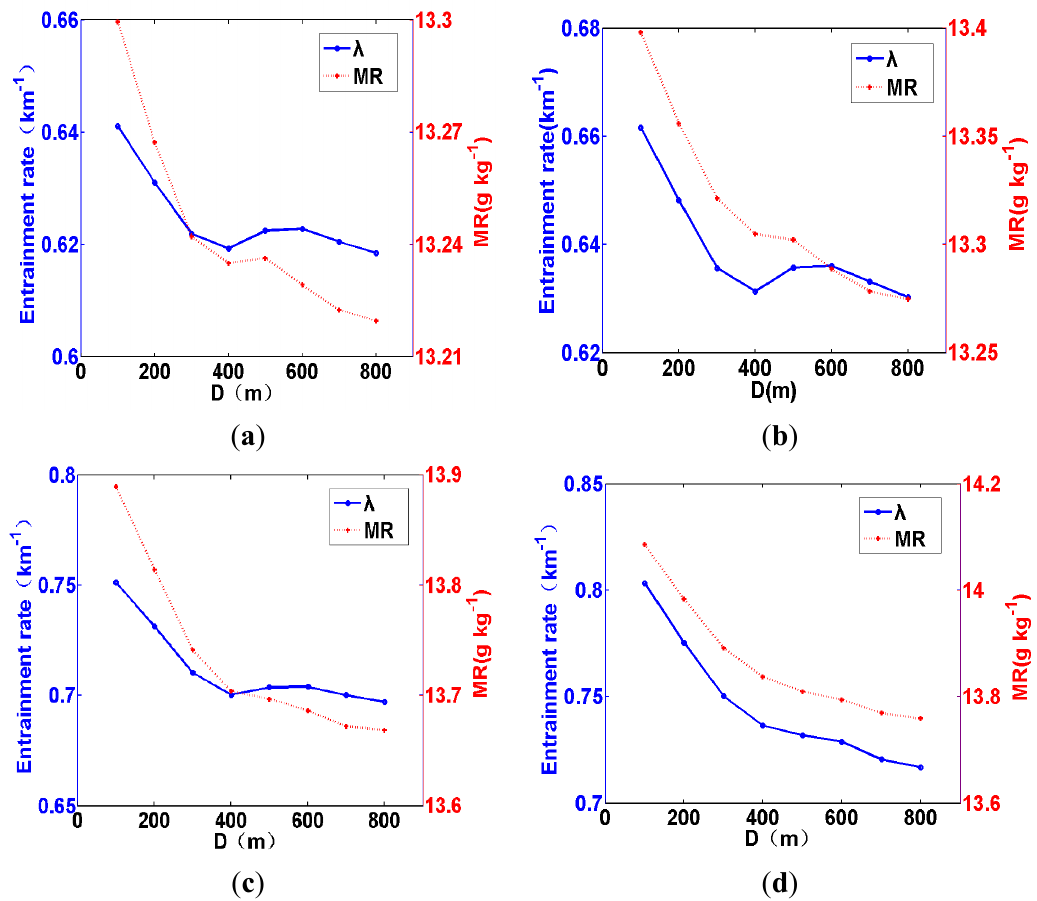
Figure 8. Entrainment rate and environmental water vapor mixing ratio as a function of distance of the assumed entrained dry air to the cloud edges when ( a ) including all clouds, and excluding the clouds the distance between which and their nearby clouds are less than ( b ) 300 m, ( c ) 600 m, and ( d ) 900